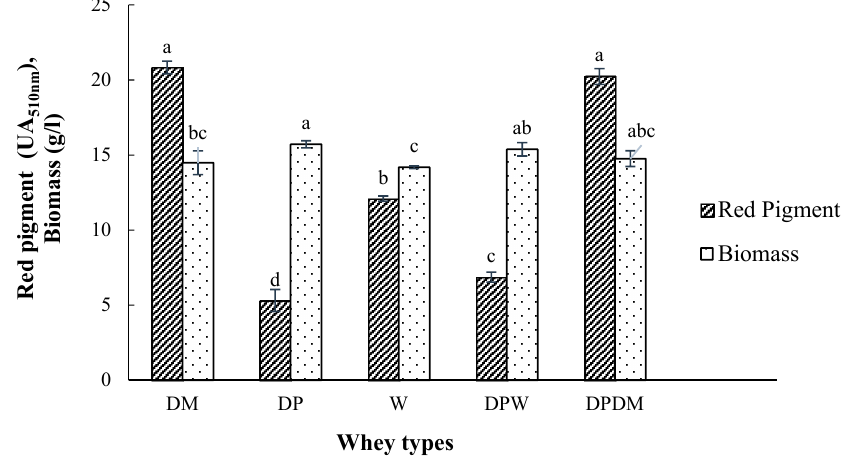
Figure 1. The effect of whey types on the red pigment and biomass production by M. purpureus CMU 001 (Fermentation conditions: 30 °C, 8 days, 200 rpm, pH 6.0, 5 g/L monosodium glutamate (MSG), 50 g/L lactose).